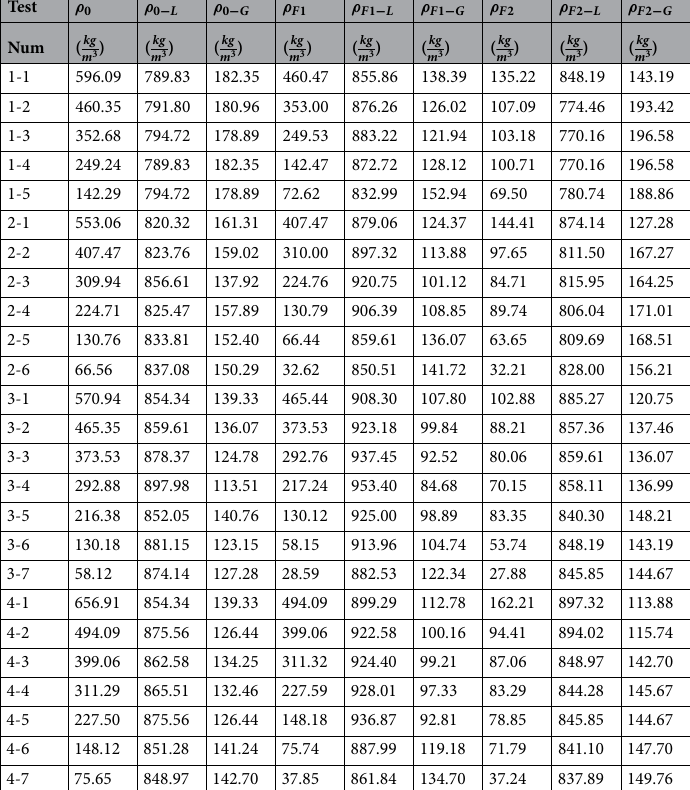
Table 7. The calculated density of CO 2 in the 3.4 liter cylinders, taken from the mass tabulated in Table 5. The densities of a saturated liquid and a saturated gas are defined with Eq.